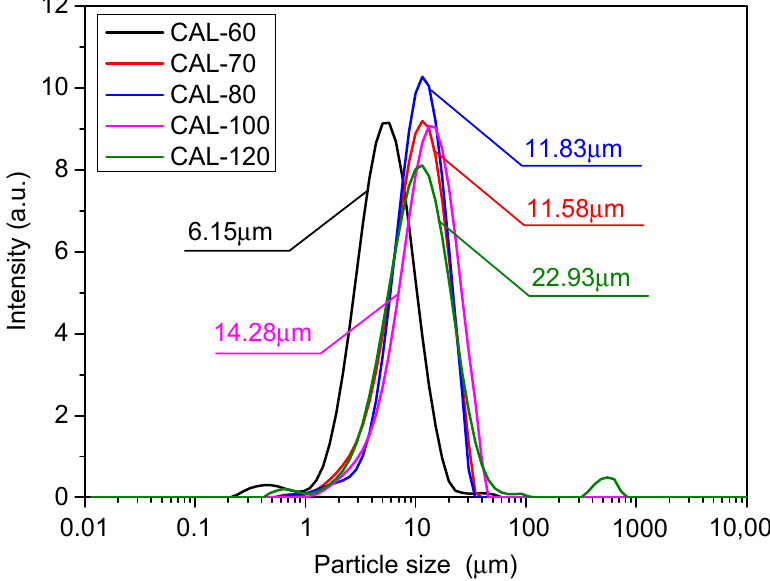
Figure 3. Particle size distribution obtained by dynamic laser scattering (DLS) analysis of the Ca-Al LDH (CAL) samples prepared at different aging temperatures.